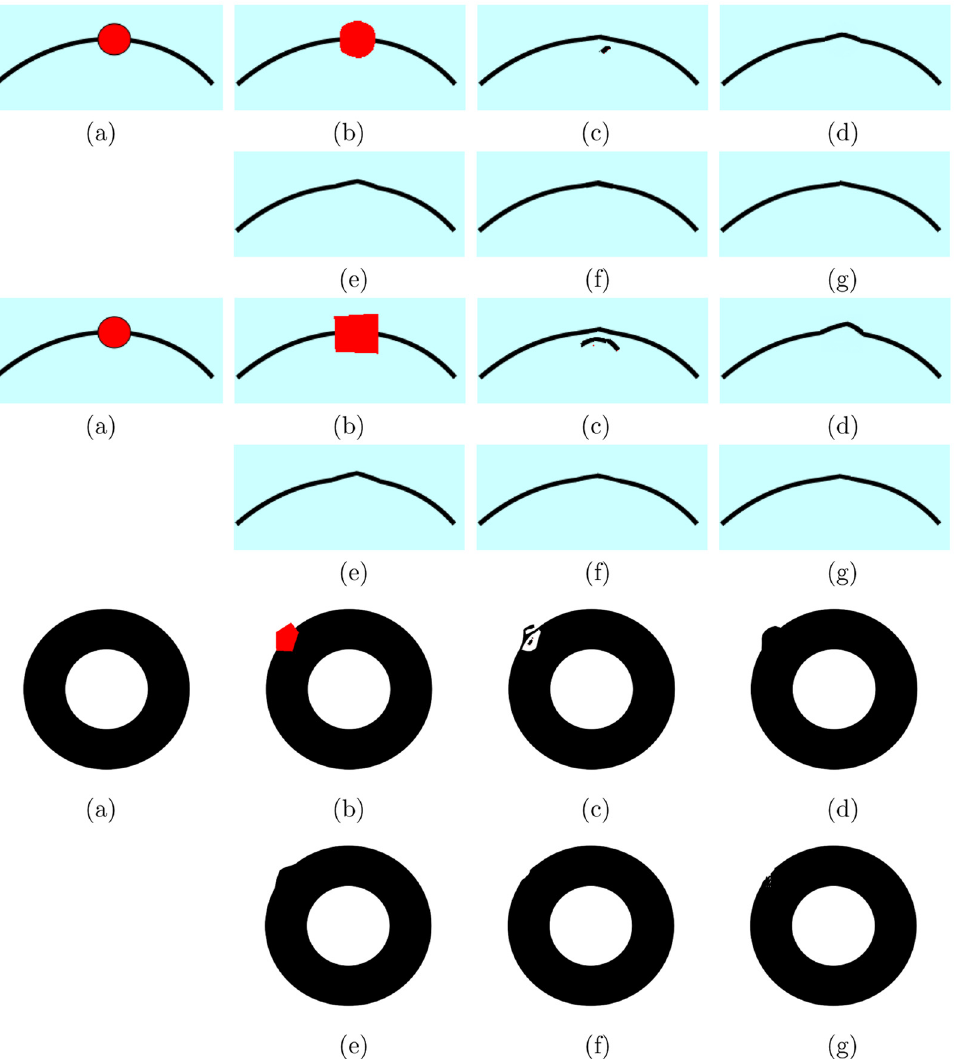
Fig 11. Test images from top to bottom: “ curveball ” (105 × 233), “ curveball2 ” (105 × 233) and “ circle ” (454 × 547). (a) The original images; (b) The original images with the red target regions; (c) Criminisi ’ s method “ 04 ’ TIP ” [23]; (d) The method “ 07 ’ TPAMI ” by Wexler et al. [18]; (e) Photoshop CS5 [16]; (f) The method “ 13 ’ TIP ” by Liu et al. [19]; (g) The proposed